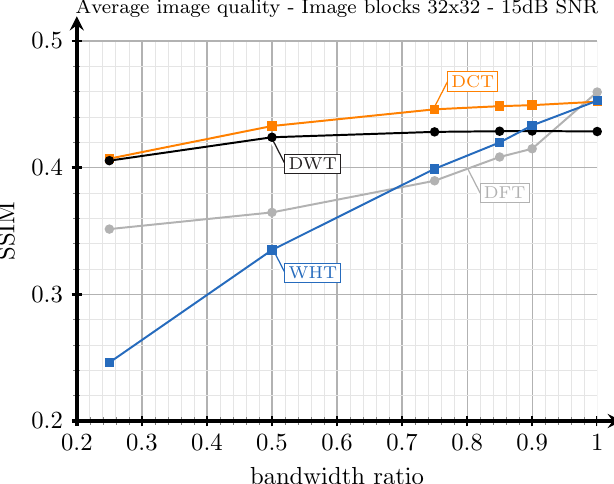
Figure 3. Relationship between bandwidth ratio (see Equation (5)) and image or video frame quality (SSIM) in an AWGN channel with an SNR of 15dB [36]. In the chart, the orange line corresponds to the DCT, the black one to the DWT, the grey one to the DFT, and the blue one to the